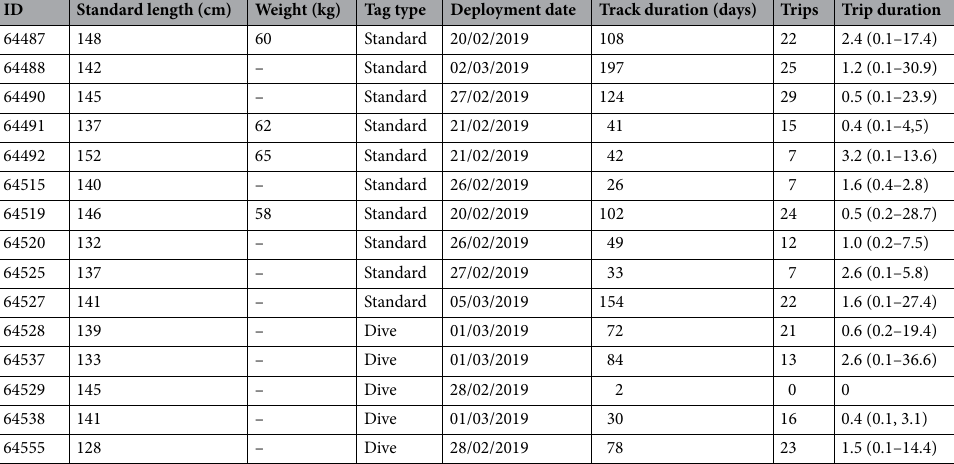
Table 1. Animal tagging data. Trip duration is reported as mean and range, in days.